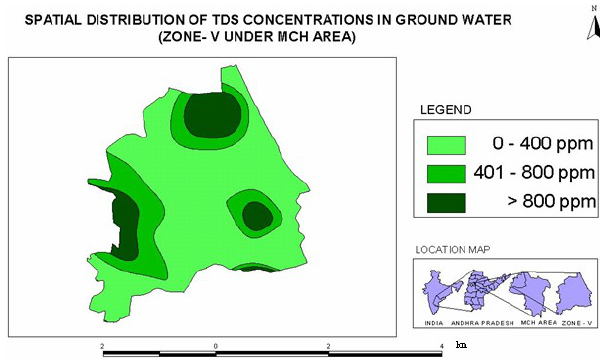
Figure 5 : Spatial Distribution of Total Dissolved Solids